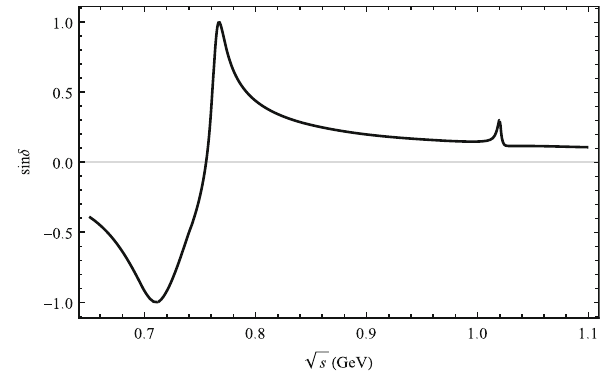
√ s corresponding to central